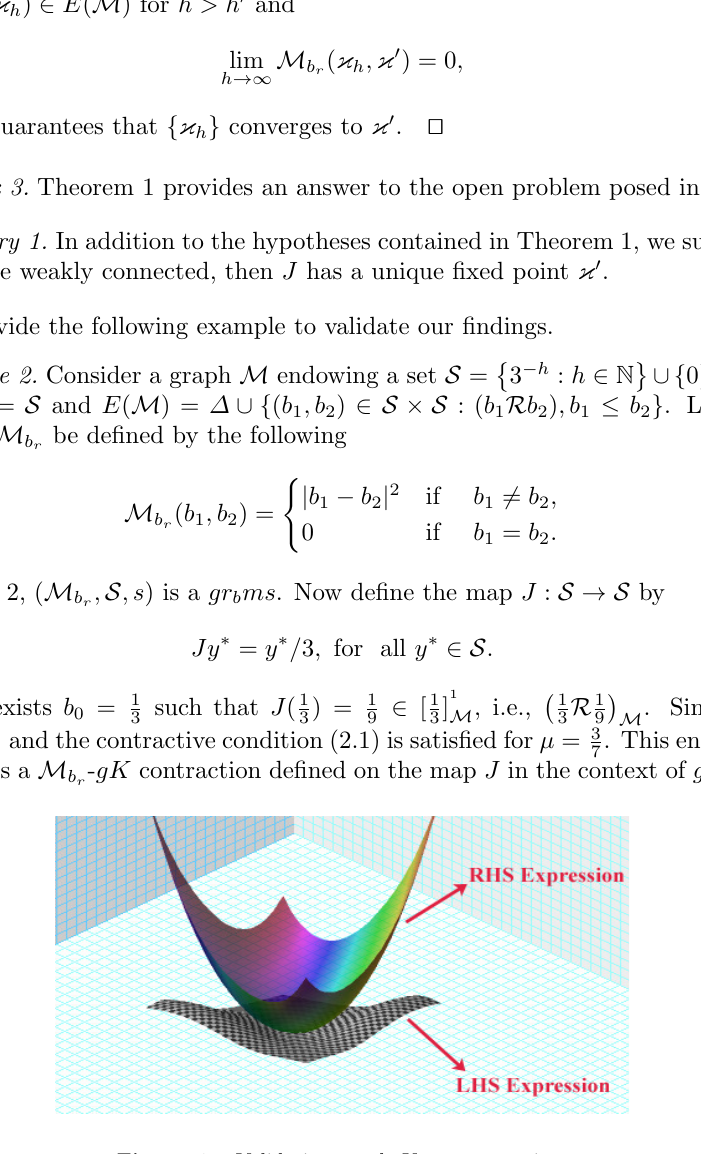
Figure 2. Validation graph–Kannan